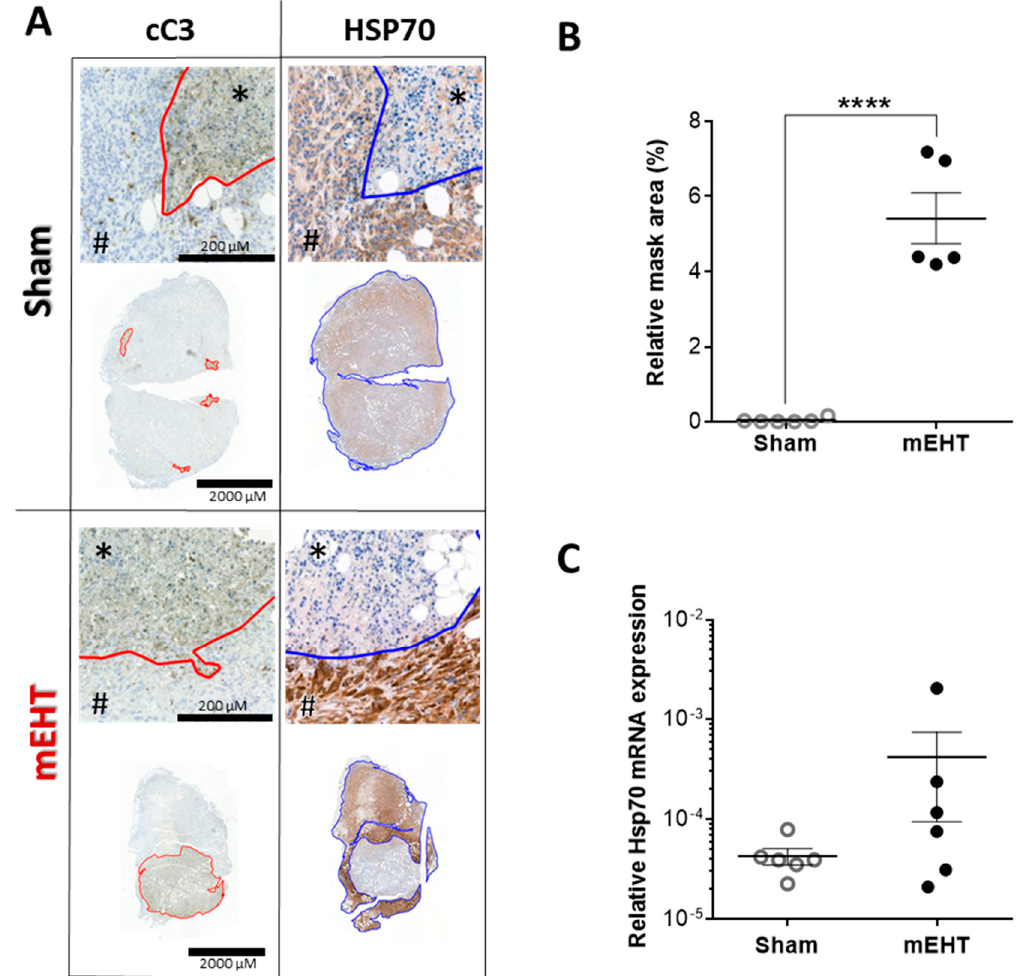
Figure 7. Heat shock protein 70 (Hsp70) expression in tumor tissue 24 h after two mEHT treatments. ( A ) Representative cC3- and Hsp70-stained sections with high and low magnification. The damaged area is cC3-positive (marked with *). The living area is cC3-negative (marked with #). Red line: the border between the damaged and living area. The Hsp70 expression was measured in the living area (marked with *). Blue line: borders of the living area; ( B ) Relative Hsp70-stained mask area of the viable tumor tissue; ( C ) Hsp70 mRNA expression (normalized to 18S rRNA); Mean ± SEM, Mann-Whitney test, n = 6/group, **** p < 0.0001 .